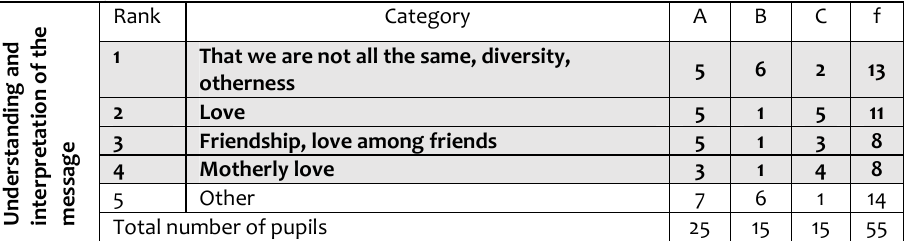
Table 9: Ranking order of the categories of answers regarding the understanding and interpretation of the message of the third example (Pablo Picasso, Pablo Picasso, Girl before a Mirror, 1932).